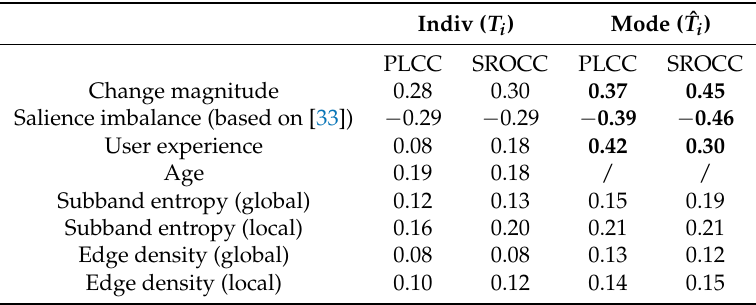
Table 1. Prediction performance of individual features. Correlation coefficients in bold font are not significantly different from each other column-wise ( p <